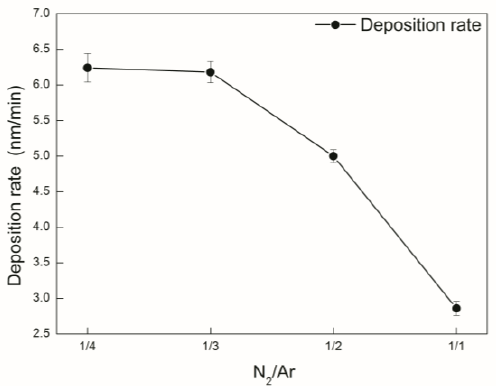
Figure 3. Deposition rate of the AlCrSiN coatings as a function of N 2 /Ar flow ratio.